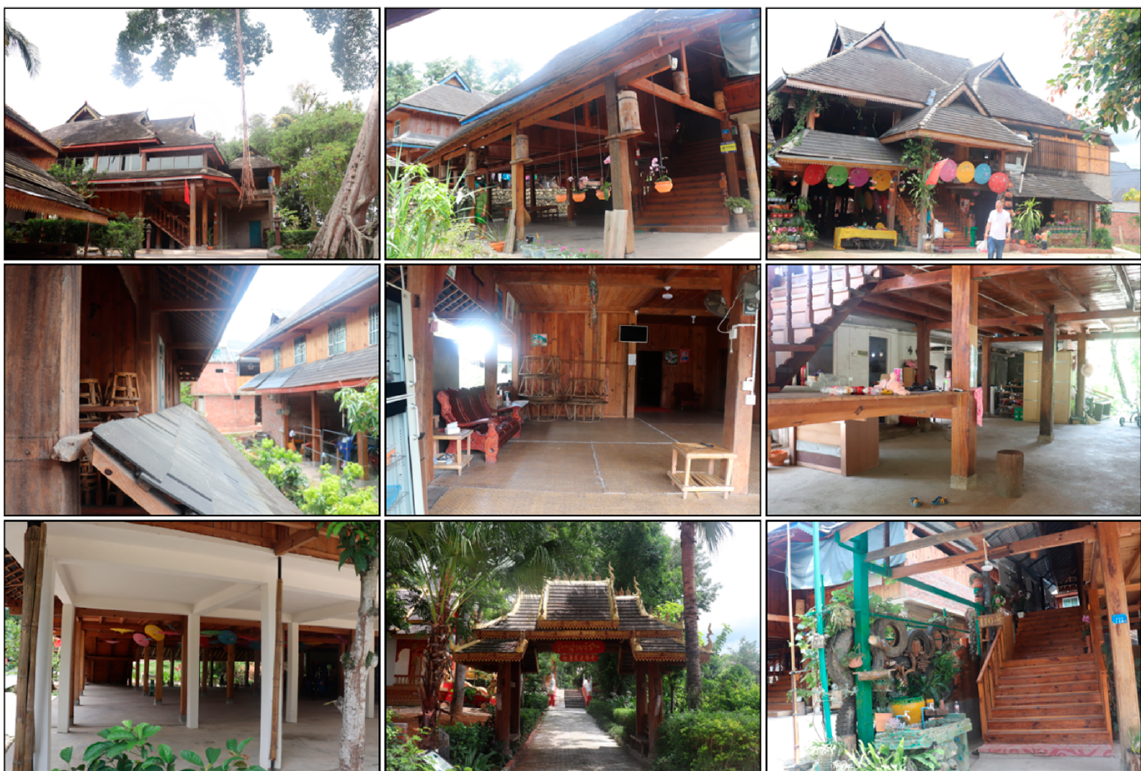
Figure 2. Selected photographs of traditional residences.